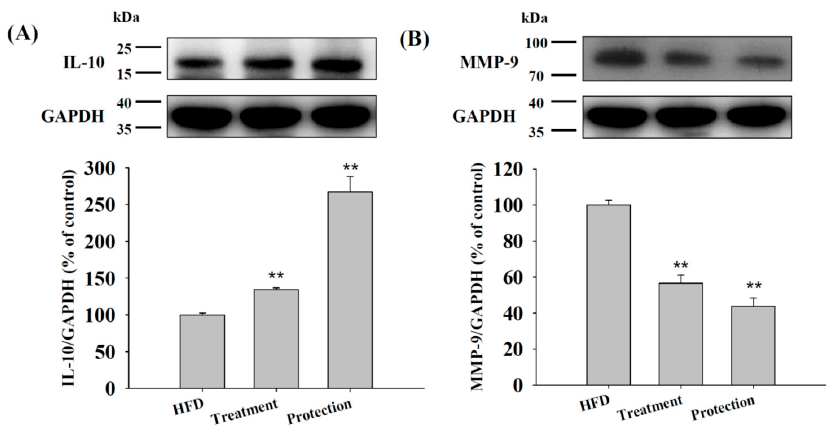
Figure 5. Expression of IL-10 and MMP-9 in mice livers treated with KMUP-1. Treatment/protection with KMUP-1 (2.5 mg/kg/day) for 6 weeks/14 weeks increased the expression of IL-10 ( A ) and decreased the expression of MMP-9 ( B ) in mice livers. The protein expression of IL-10 and MMP-9 was described in Materials and Methods. Data are means ± S.E. of six independent experiments. ** p < 0.01 versus HFD group.